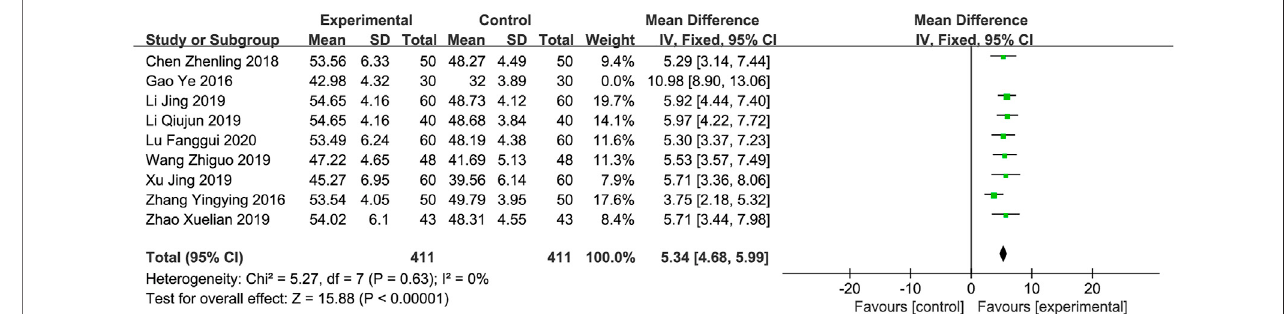
FIGURE 2 | Forest plot of LVEF.